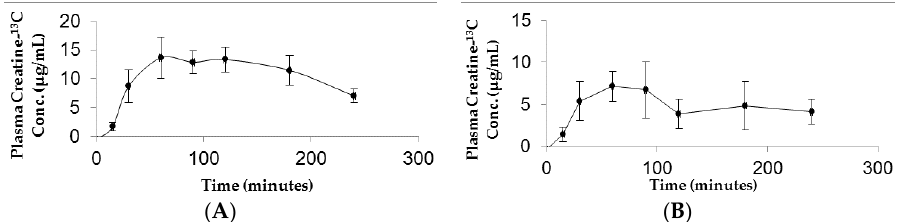
Figure 3. Plasma concentration–time curve following administration of ( A ) high dose (70 mg/kg) or ( B ) low dose (10 mg/kg) oral CM- 13 C. Values represent the mean ± SEM. n = 4 rats.